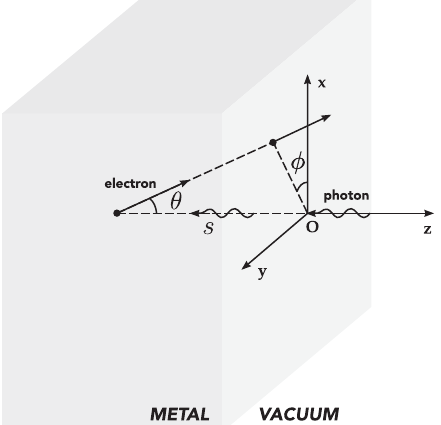
FIG. 1. The schematic plot for the bulk photoemission on a smooth metallic cathode. The definitions of coordinates and variables are marked in the